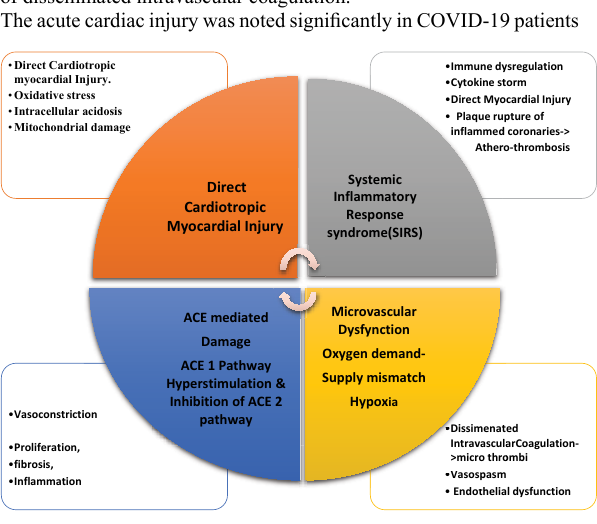
Figure 2: Wagon wheel of pathophysiology in acute cardiac injury by